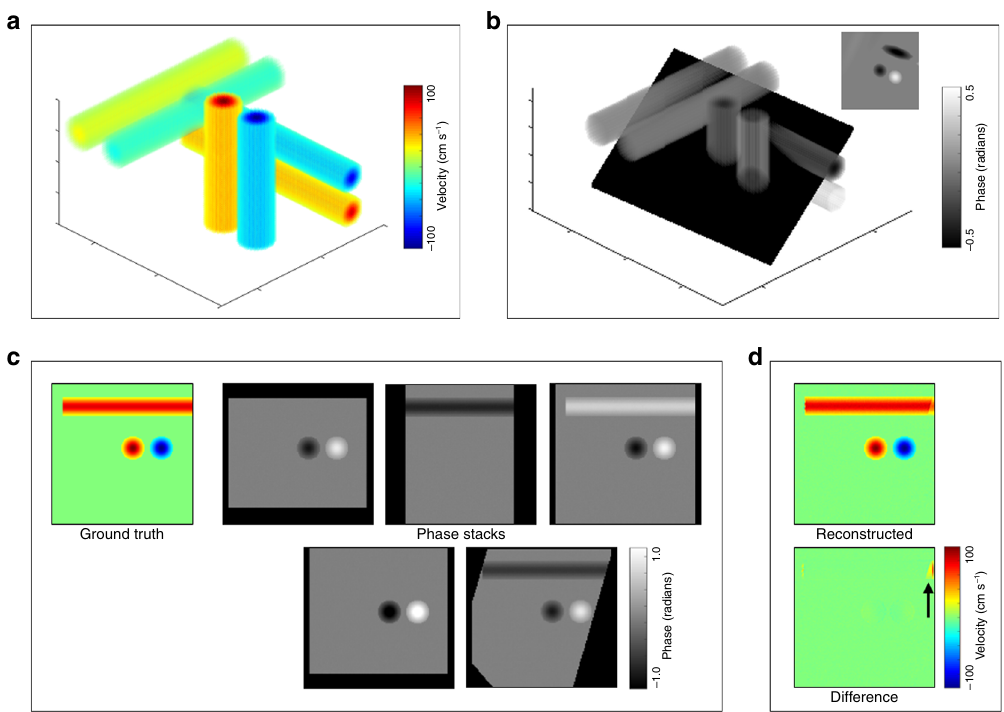
Fig. 1 Velocity encoding with multi-planar stacks in a simulated fl ow phantom. a The simulated fl ow phantom consisted of six orthogonal pipes with variable fl ow velocities (±25, ±80, ±100 cms − 1 ). b Example of a possible oblique slice projection (black plane) through the phantom and, inset, the corresponding in-plane phase image. c Ground truth fl ow velocities (color) and phase images (greyscale) from fi ve non-coplanar stacks. The planes displayed are all positioned at the same spatial location. The phase values in the pipes change depending on the orientation of the stack. d Three-directional velocity reconstruction at an equivalent location to c and the corresponding subtraction image to show reconstruction errors. Black arrow shows region not covered by all phase